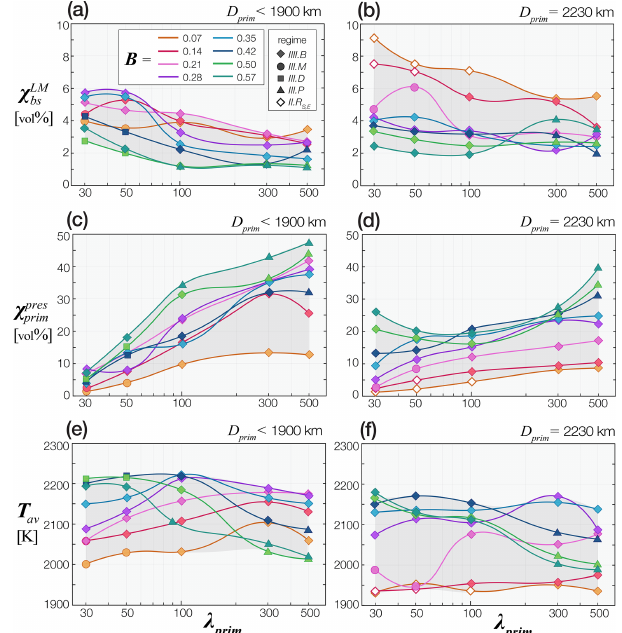
Figure 3. Summary of key results as a function of physical param- eters of primordial material for model suite 1 (see text). The verti- Figure 4. Output quantities time-averaged between 4.25 and cal axis represents the initial buoyancy ratio B , defined at 1500km 4.5Gyr for the main model suite (a, c, e) and test model suite (b, d, depth (Sect. 2 and Supplement S3), or the corresponding Mg num- f) : (a–b) primordial preservation factor χ pres in vol% of initialized ber of primordial material. The horizontal axis gives the viscos- prim ity contrast λ prim between primordial and pyrolitic material in the primordial material, (c–d) average mantle temperature, and (e–f) convective vigor. The horizontal axis represents the primordial vis- lower mantle. The fraction of primordial heterogeneity ( χ LM , red) prim cosity contrast λ prim , while colors denote different B used in the and ROC ( χ LM , blue) in the lower mantle is averaged between 4.25 ROC and 4.5Myr model time (for definitions, see Supplement S1.3). The circle denotes the reference model in this study. Regime boundaries are established based on the style of mantle evolution and chemi- cal heterogeneity: (III) partial heterogeneity preservation as marble- cake mantle (M), marginally stable piles (P), viscous blobs (B), or diffuse domains (D).